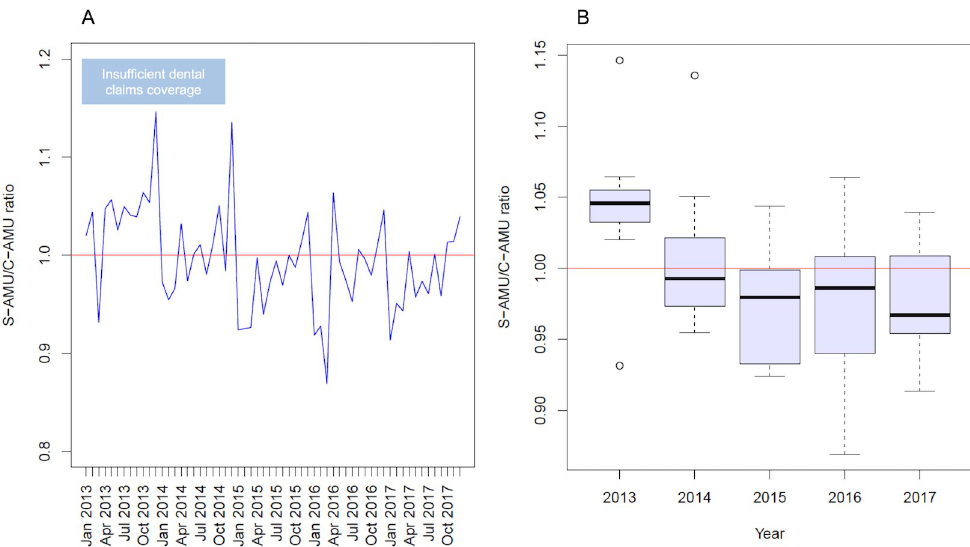
months was less than 1 from 2015, meaning that C-AMU was higher than S-AMU.